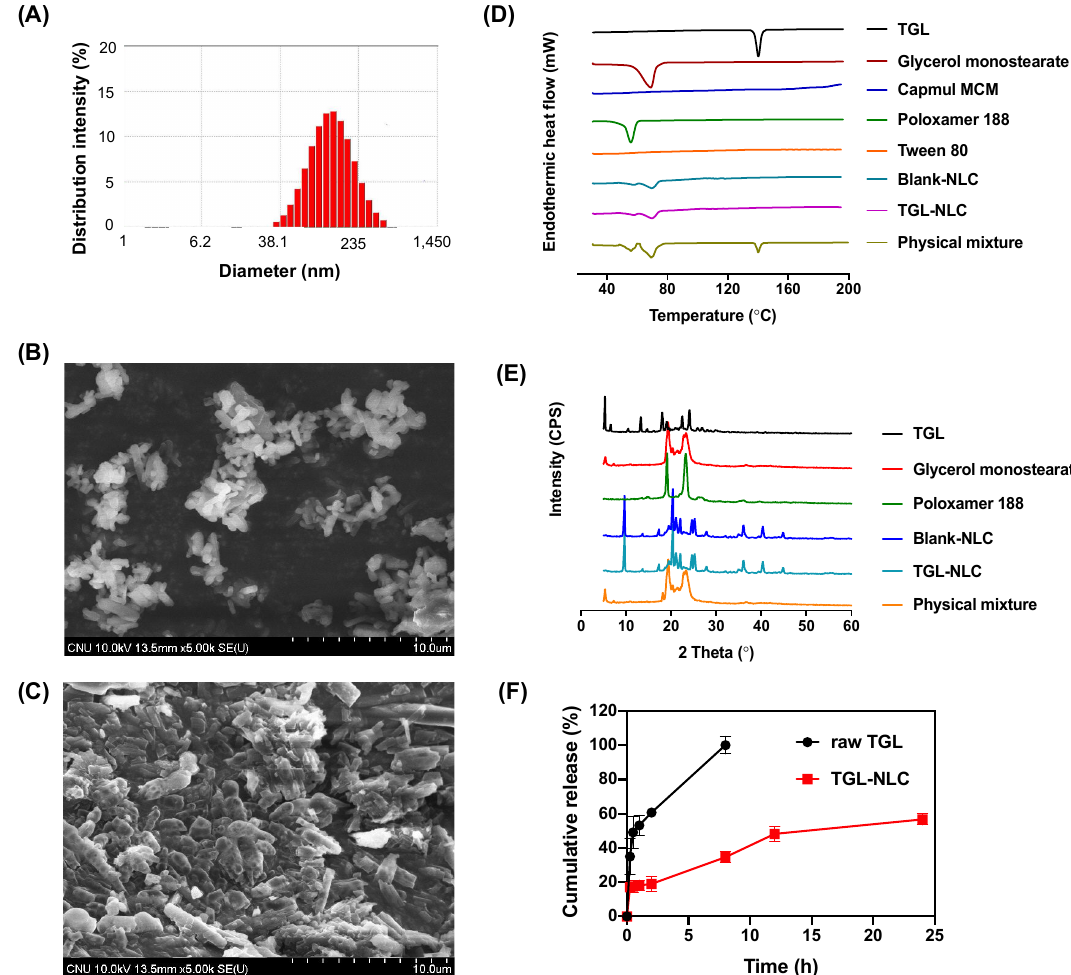
Figure 3. ( A ) Particle size distribution of TGL-NLC measured with electrophoretic light scattering (ELS) analyzer. The SEM image of ( B ) raw TGL and ( C ) TGL-NLC. ( D ) DSC thermograms of raw TGL, glycerol monostearate, Capmul MCM, poloxamer 188, Tween 80, blank-NLC, TGL-NLC, and physical mixture. ( E ) PXRD patterns of raw TGL, glycerol monostearate, poloxamer 188, blank-NLC, TGL-NLC, and physical mixture. ( F ) In vitro TGL release profiles of raw TGL and TGL-NLC in pH 1.2 medium with 1 w/v % Tween 80. Data are expressed as the mean ± SD (n = 3). Abbreviation: SEM, scanning electron microscopy; DSC, differential scanning calorimetry; PXRD, powder X-ray diffraction; blank-NLC, nanostructured lipid carriers without ticagrelor.